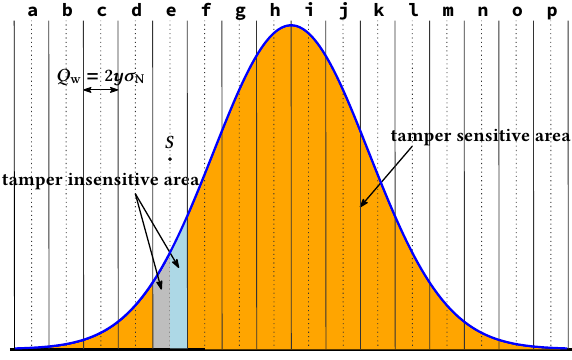
Figure 3: TS max of Profile 1. Any shift outside of the marked quantization interval causes node the detection of a tamper attempt which causes the device to fail (as